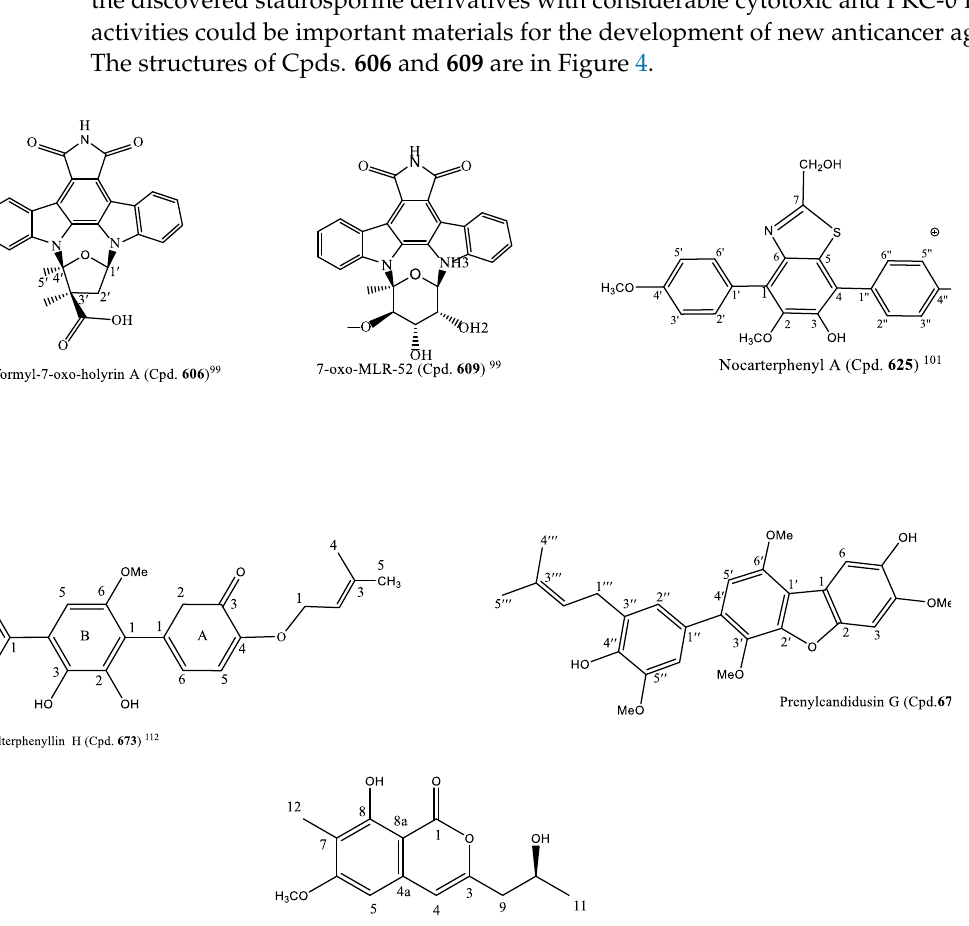
Figure 4. The structure of other novel marine-derived compounds cytotoxic to cancer cell lines at IC 50 ≤ 1 µM .